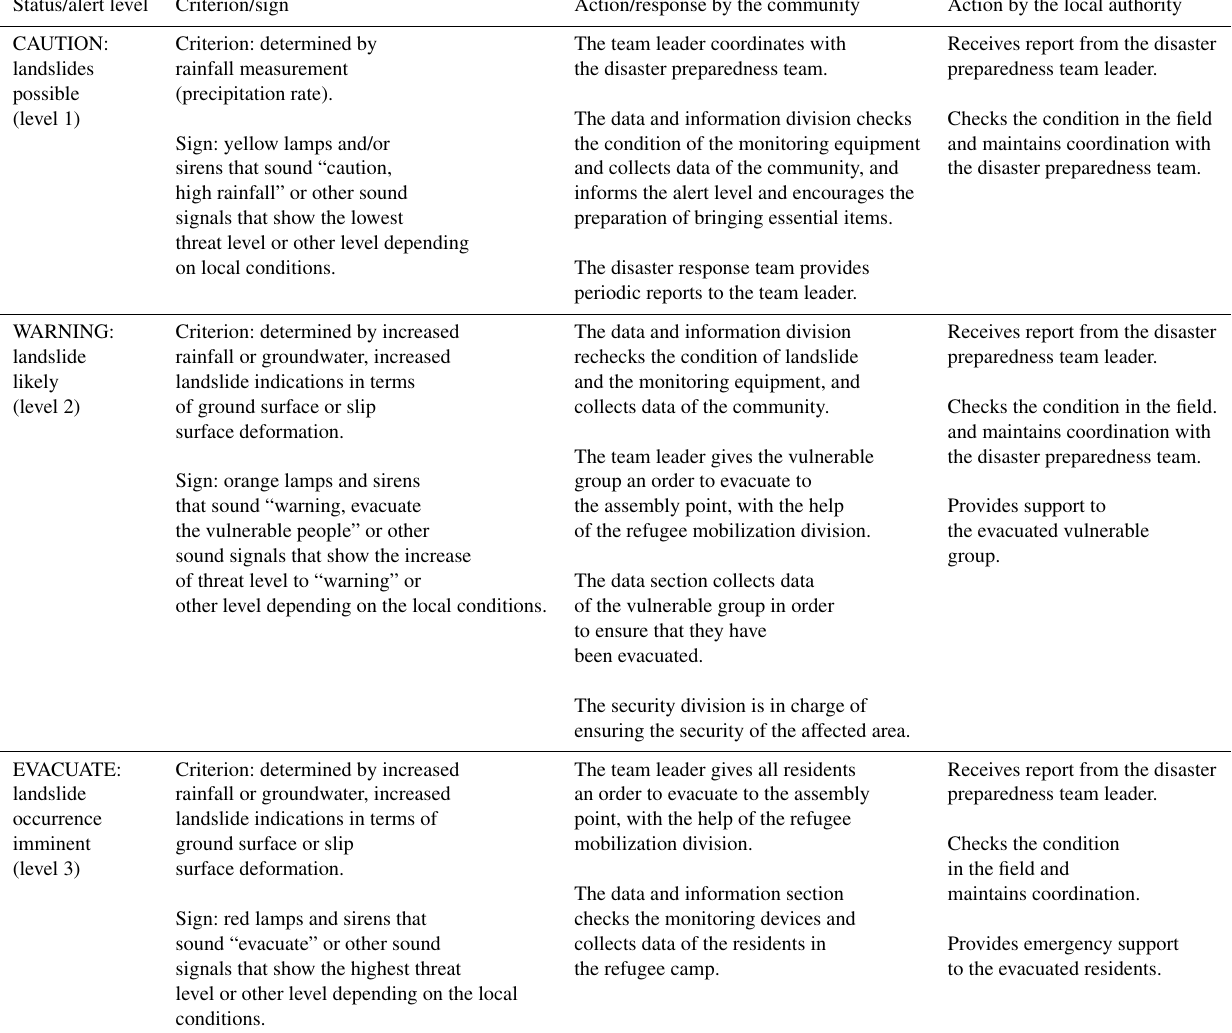
Table 1. Typical evacuation SOP to support a landslide early warning